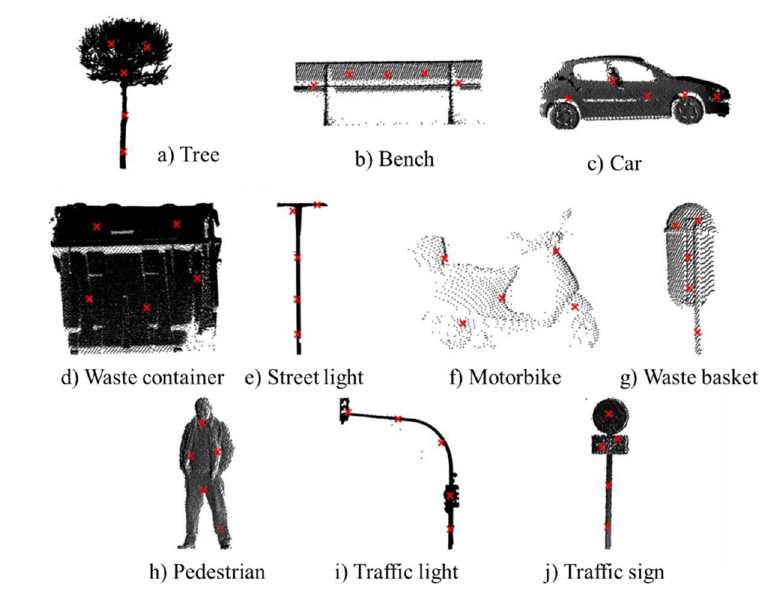
Figure 7. Distribution of occlusion origins (red points) in point cloud objects.